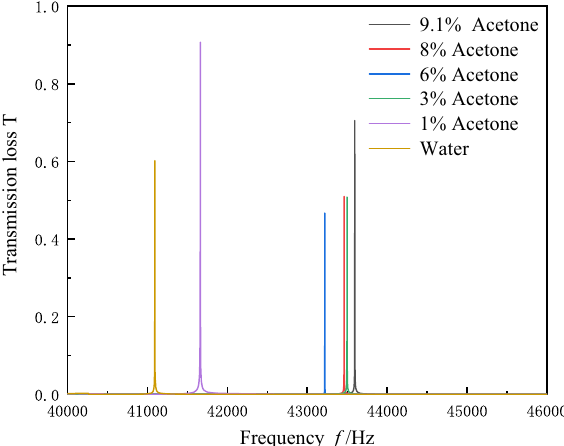
Figure 7. Acoustic transmission spectrum of 0—9.1% acetone solution sensed by PnC sensor.